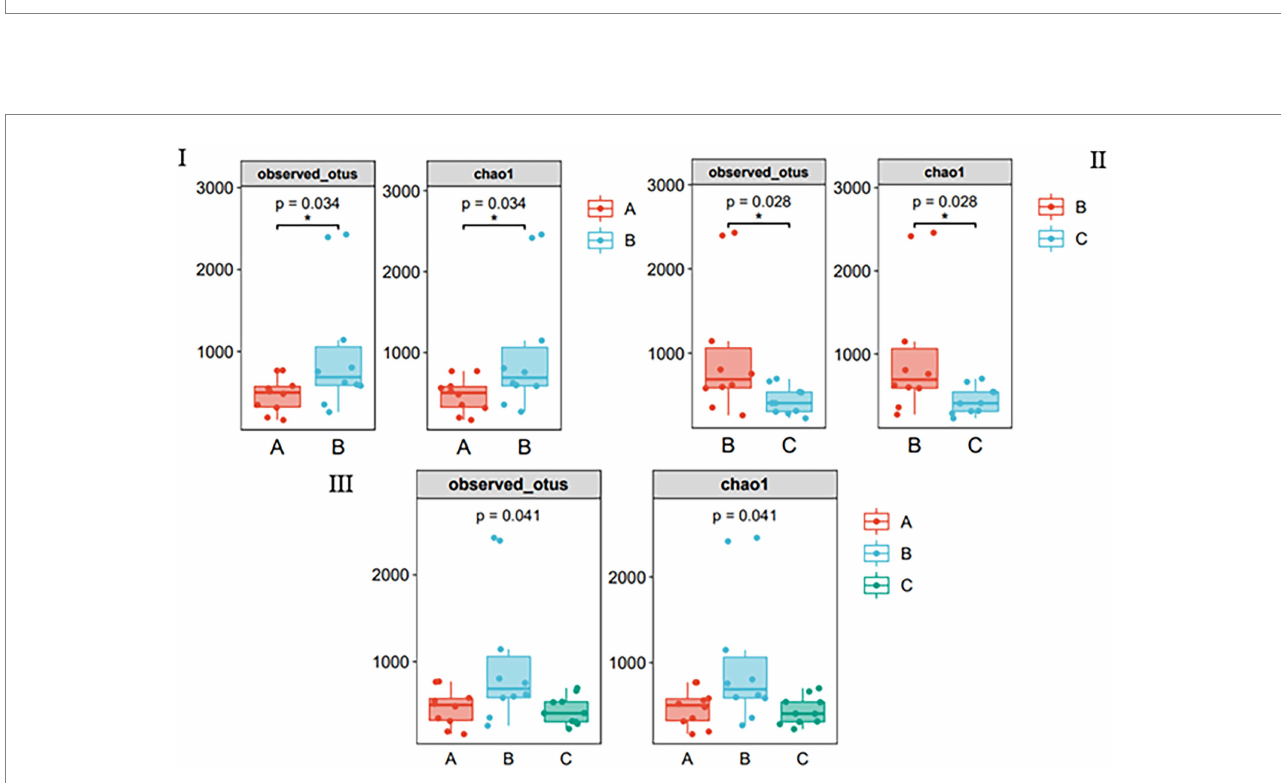
FIGURE 2 Species richness of gut bacteria of the wild Arborophila rufipectus and Lophura nycthemera measured via 16S rDNA sequencing (* p < 0.05). (I) Comparison of observed_otus and chao1 index between groups A and B. (II) Comparison of observed_otus and chao1 index between groups B and C. (III) Comparison of observed_otus and chao1 index between groups A, B, and